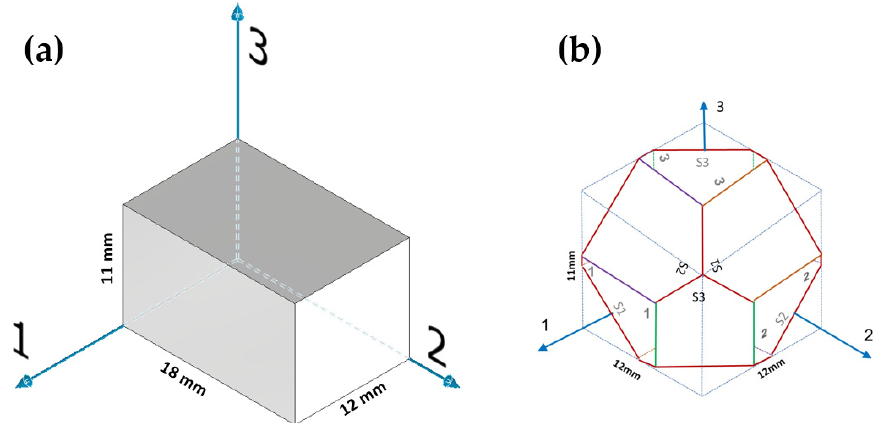
Figure 3. Two-step sample preparation and TOF measurement sequence for DED and SLM samples. ( a ) A 18 mm × 12 mm × 11 mm parallelogram sample utilized for measuring nine TOF V ij (i,j = 1,2,3) values. ( b ) A small polygon sample utilized for measuring three TOF V si (i = 1,2,3) values. Using the so-obtained small polygon samples, three additional TOF V si (i = 1–3) were measured.